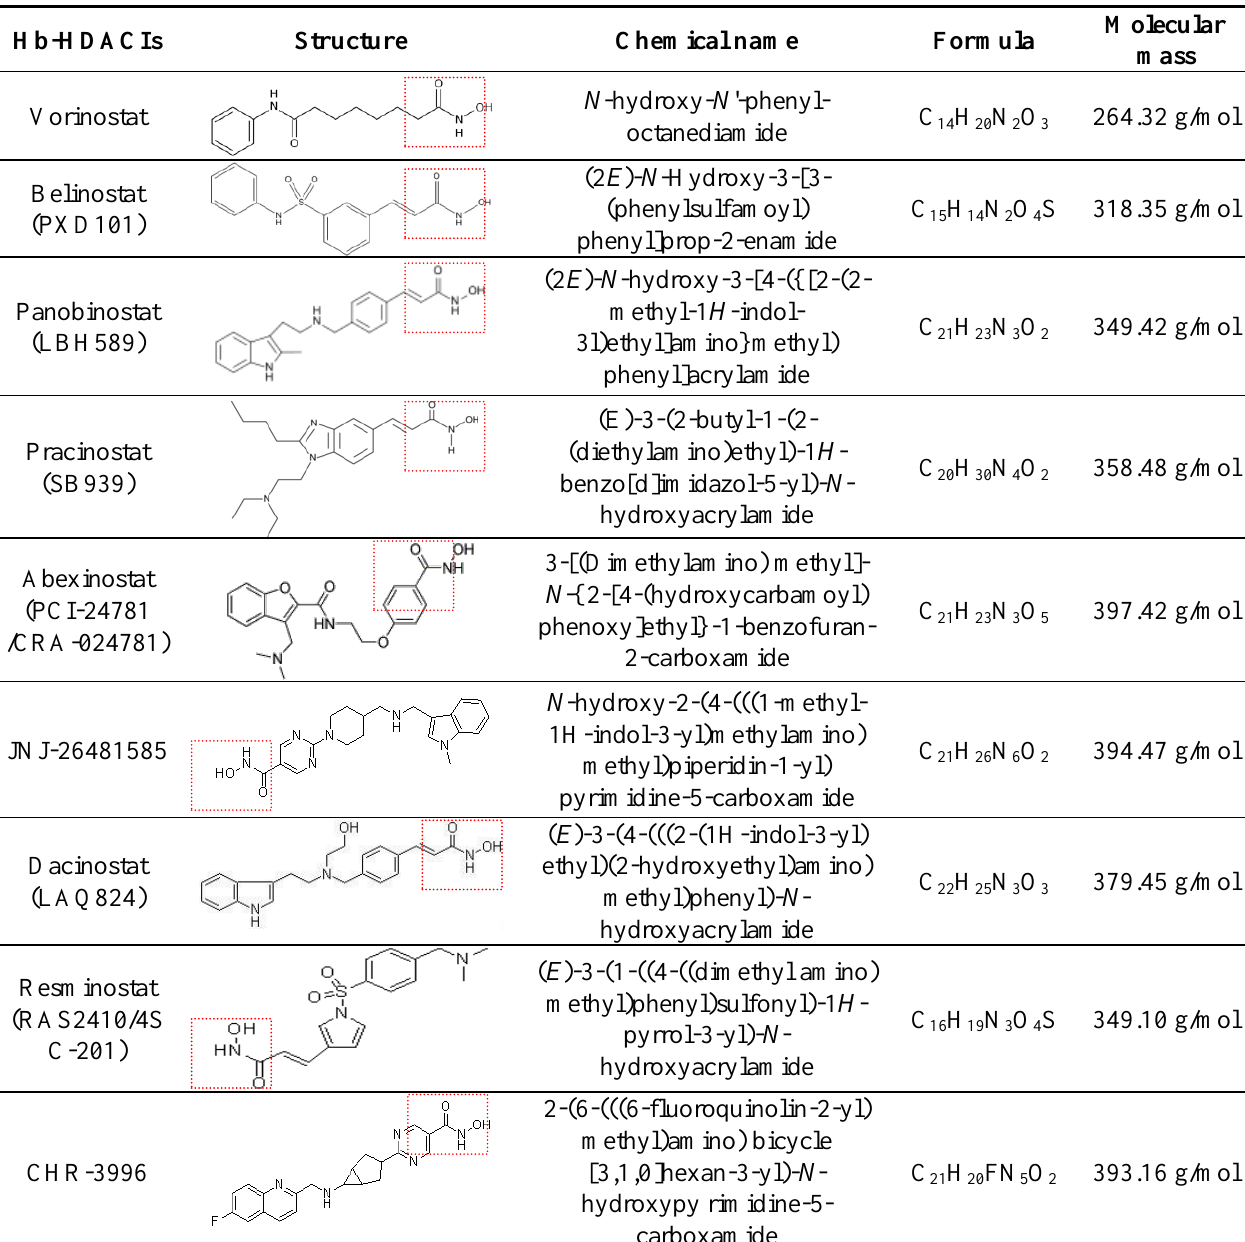
Table 1. Hb-HDACIs in clinical trials for cancer treatment. The hydroxamic acid group, which characterizes this class of HDACIs, is represented in the red dotted